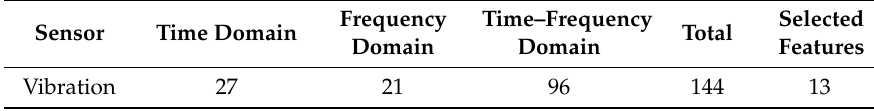
Table 3. Features selected for vibration signals in three